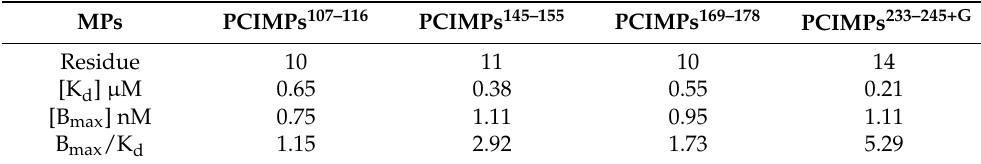
Table 1. Binding affinity values of various PCIs on magnetic particles (PCIMPs) to PPT.